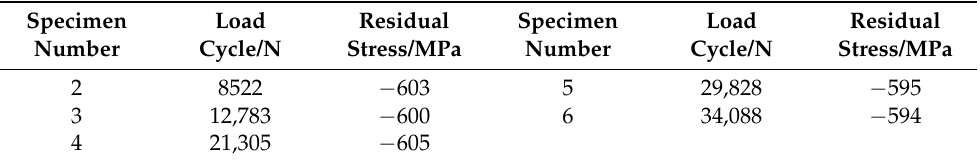
Table 3. The residual stress of specimen No. 2–6; specimen No. 2–6 were removed at a specific ratio of the total loading period of specimen No. 1, and the fatigue cycle was measured, which was operated only